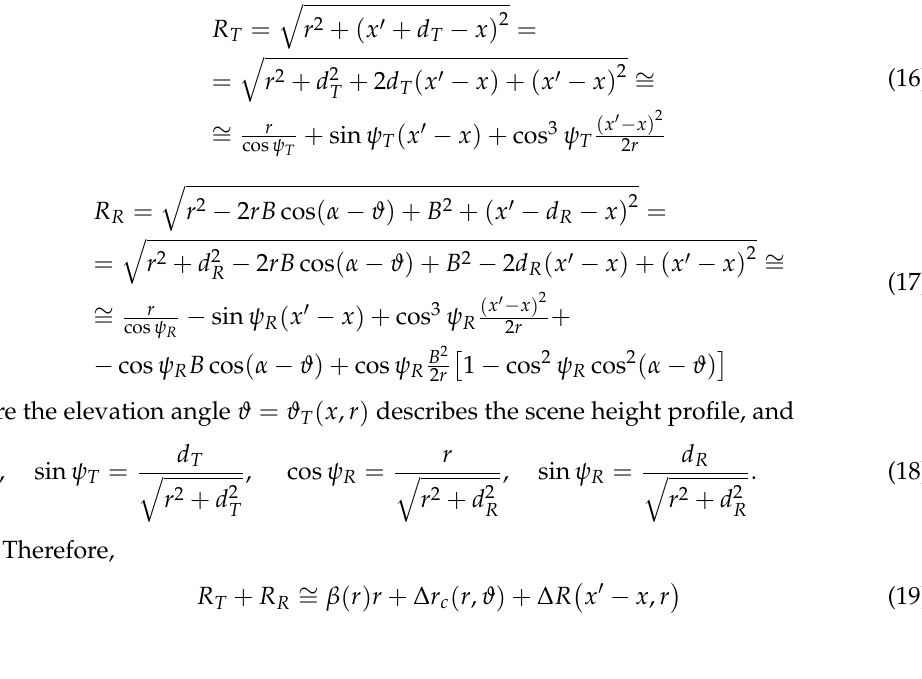
Figure 3. Geometry of the TI bistatic SAR configuration: ( a ) 3D view; ( b ) cross-track plane view. In view of (11) and (12), the target-to-sensors distances R T and R R can be written